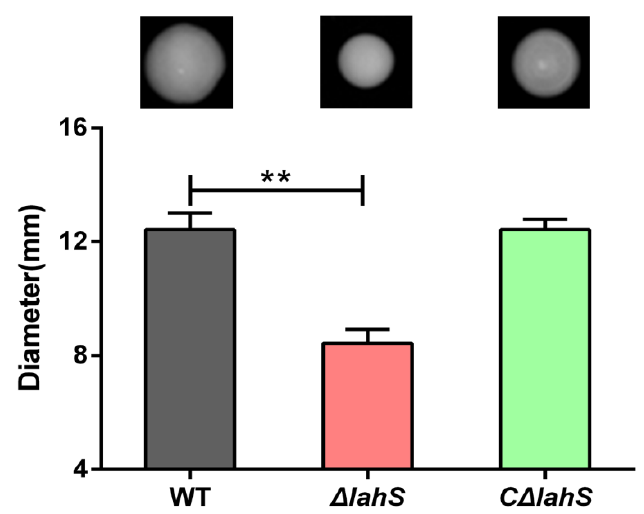
Figure 5. Motility of the wild-type and lahS mutant strains. Swimming ability was observed after culturing strains at 28 °C for 48 h on 0.3% Luria Bertani broth (LB) agar plates. The migration diameters were measured to assess the motility. The results are presented as the means ± SEM from three independent replicates. ** p < 0.01.